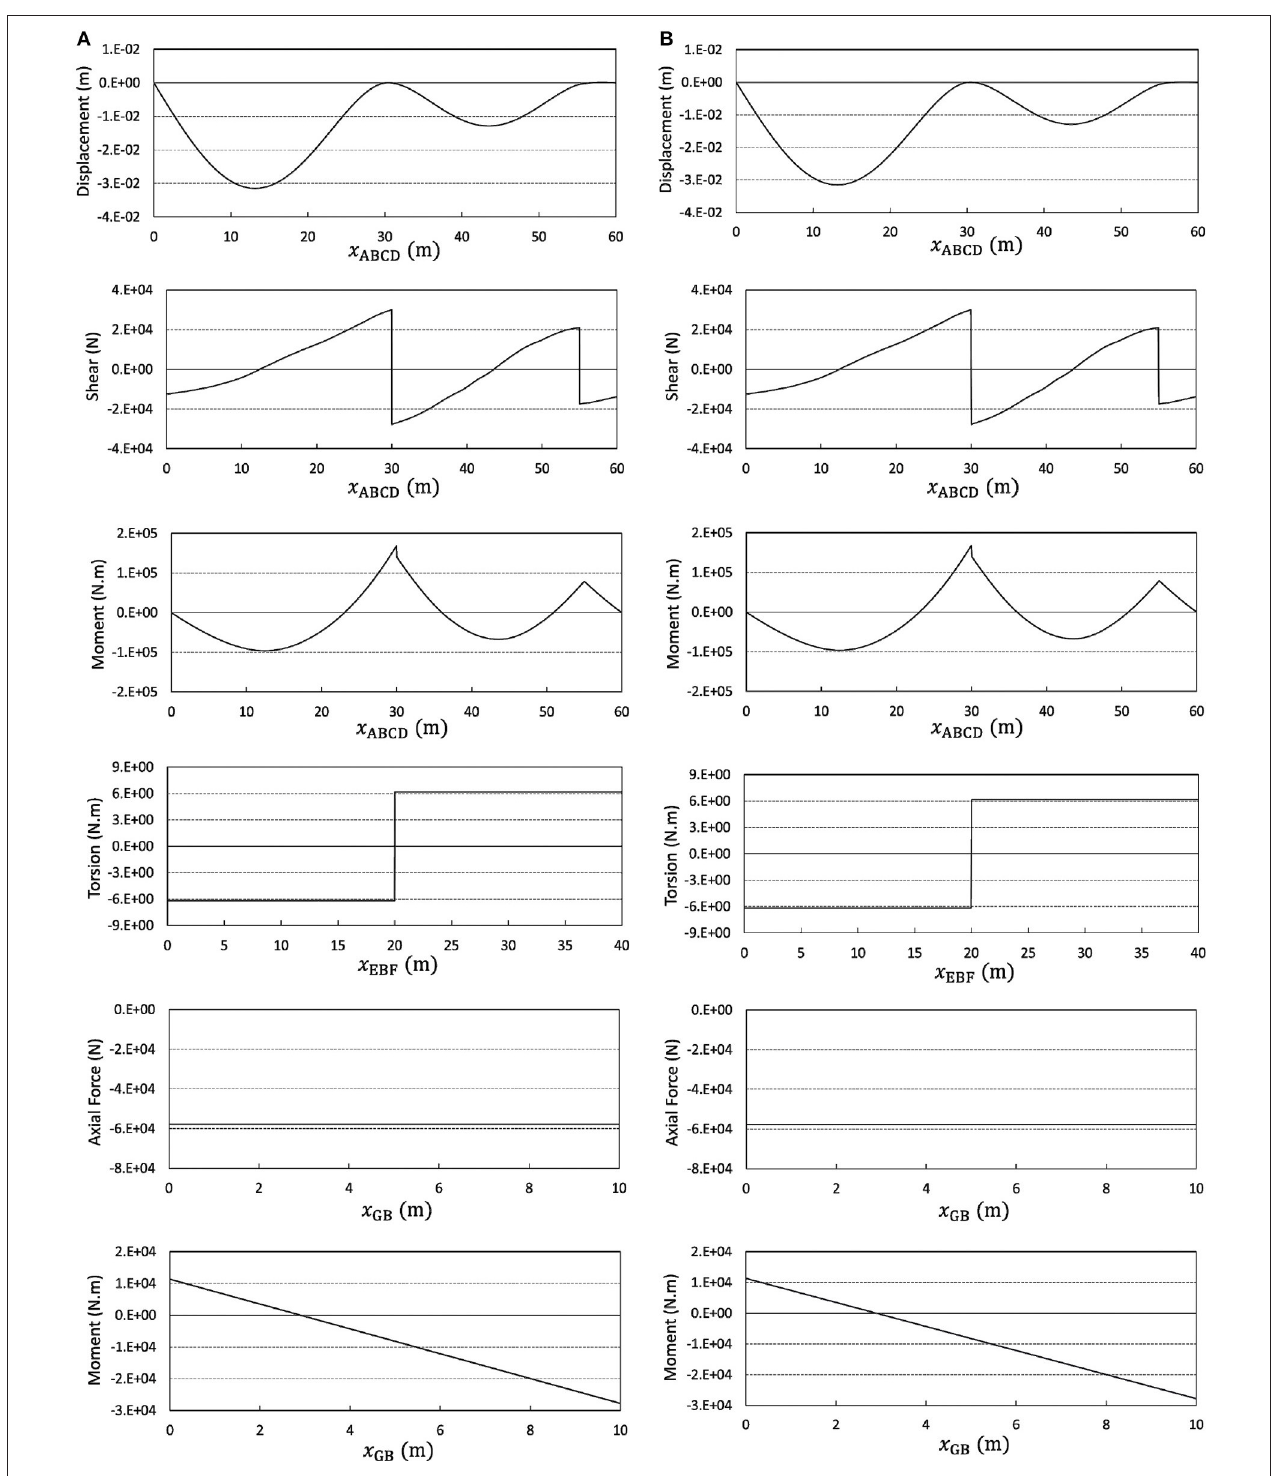
FIGURE 11 | Responses of the fourth example obtained from finite element analysis using elements sized (A) f 1 x and (B) 4 f 1 x .